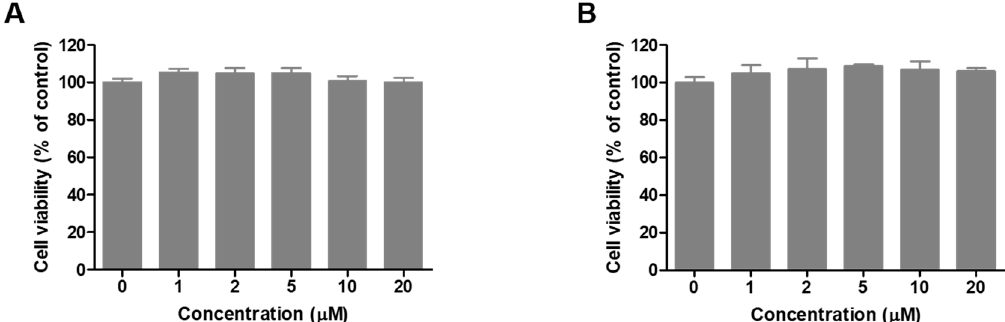
Figure 5. Cell viability of compound 8 in B16F10 melanoma cells. B16F10 cells were seeded in 96-well plates, and various concentrations of 8 were treated for 24 h ( A ) or 48 h ( B ).